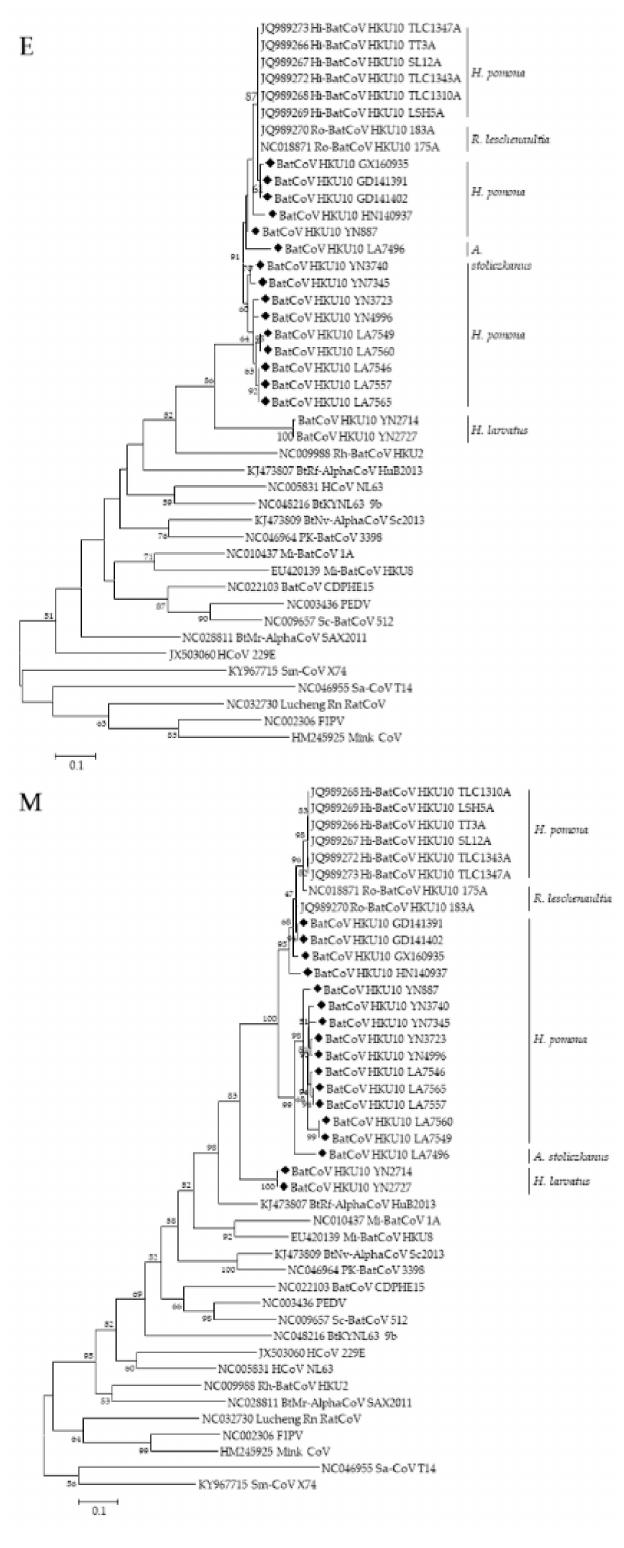
Figure 4. Phylogenetic trees of pp1ab (aa sequences), (S, N, M, E) (nt sequences). Trees were constructed by the maximum likelihood method using the Poisson model with bootstrap value determined with 1000 replicates. The scale bar indicates the estimated number of substitutions per 10 amino acids or nucleotides. Filled diamonds indicate viruses detected in this